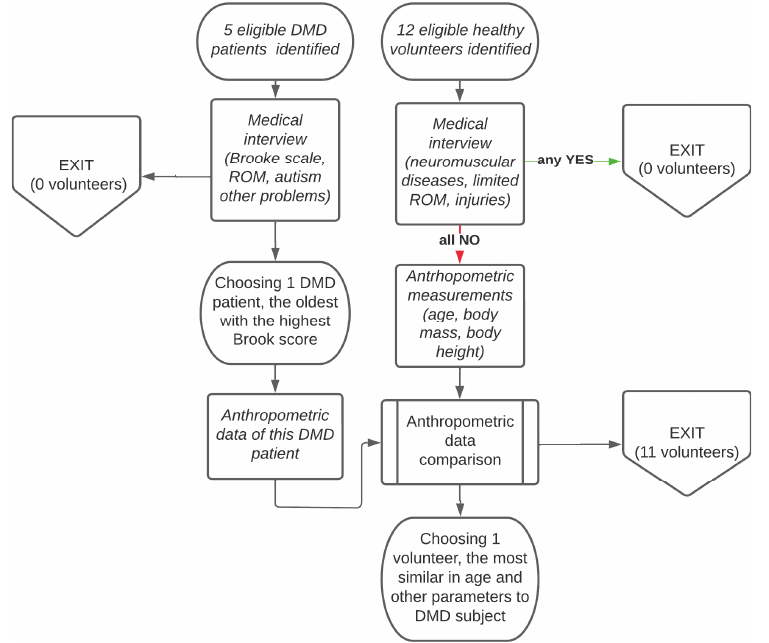
Figure 1. Flow chart of patient quantification process and the pair (DMD–RS) chosen for comparison.